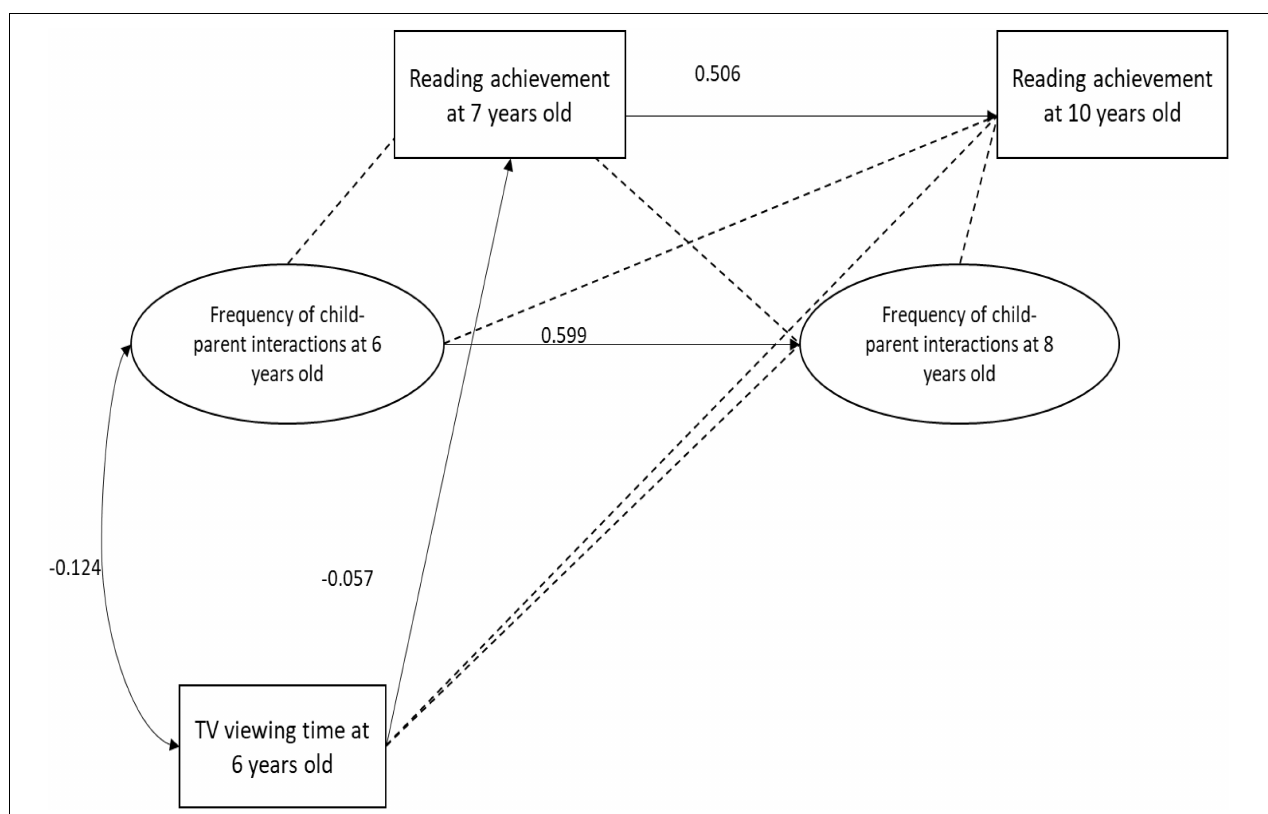
FIGURE 2 | Parent-child interaction mediation model. Dotted line indicates a p -value above